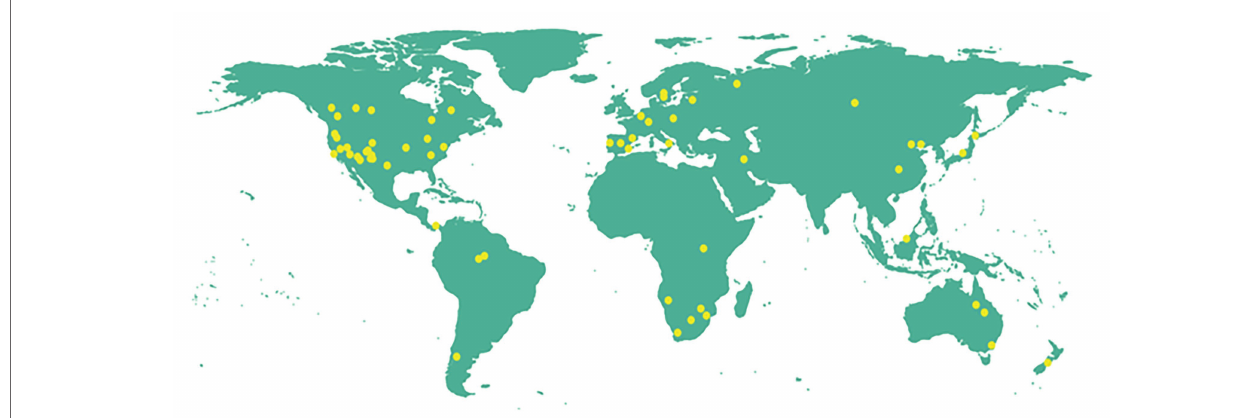
Table 2 . We searched on Google scholar using different combinations of the key words: “tree,” “forest,” “vegetation,” “plantation,” “massive,” “mortality,” “die-off,” “die-back,” and “decline.” Reports from relevant reviews (Allen et al., 2010, 2015; McDowell et al., 2018) were also searched. Reports which do not indicate the spatial characteristics and intensity of mortality as well as those which include other exogenous mortality agents such as fire, flood, etc., were excluded. In addition, seedling mortality, mortality due to experimental stress, long term mortality analyses were not included. Then, reports which clearly describe individual mortality event/events and can be approximated as landscape scale according to the classification given in Lugo and Scatena (1996) were selected. Reports describing different aspects of the same mortality event at the same location were considered as single